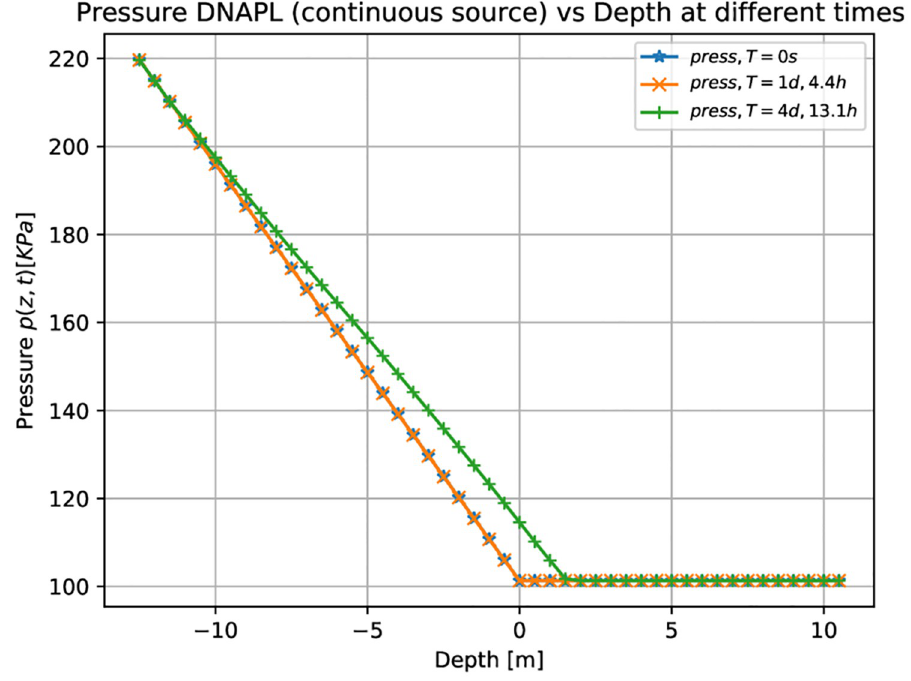
Fig 7. Pressure vs. Depth for DNAPL (continuous source) at different times. Three-dimensional numerical result on the pressure as a function of the depth for a continuous leak of DNAPL at different times. Initially, at t = 0 s (blue points), the pressure is equal to one atmosphere in the unsaturated zone composed of air and the contaminant. Then the pressure increases as the contaminant goes downward the groundwater table to the bottom, up to a value of 220 KPa .